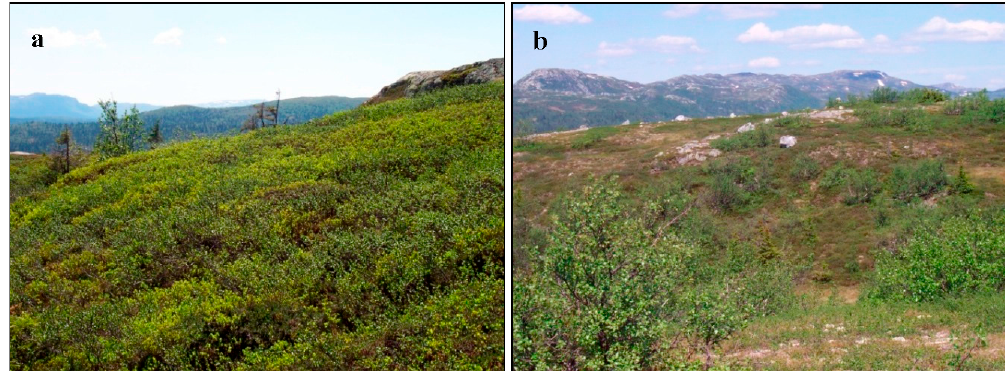
Figure 3. Photographs taken from a central part of the study area towards south ( a ) and north ( b ) showing the stage of vegetation development as observed in the field at 11:00 a.m. UTC on 10 June 2007. The ALS data were acquired at 3:20–3:55 p.m. UTC on 11 June 2007. Apart from a few wet spots with some dead grass from the previous year still visible, the ground vegetation appeared fully developed.